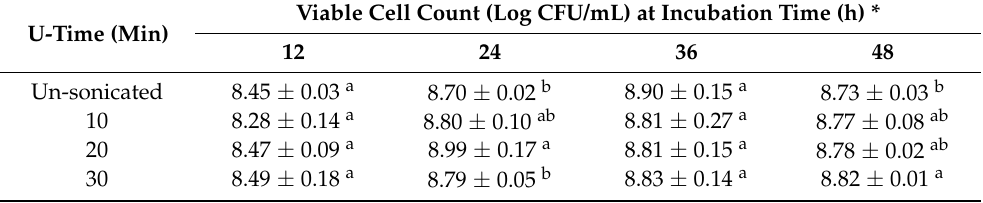
Table 1. Effect of different durations of ultrasonic treatment (40 kHz/300 W) (U-time) on viable cell counts of encapsulated L. plantarum BCRC10357.